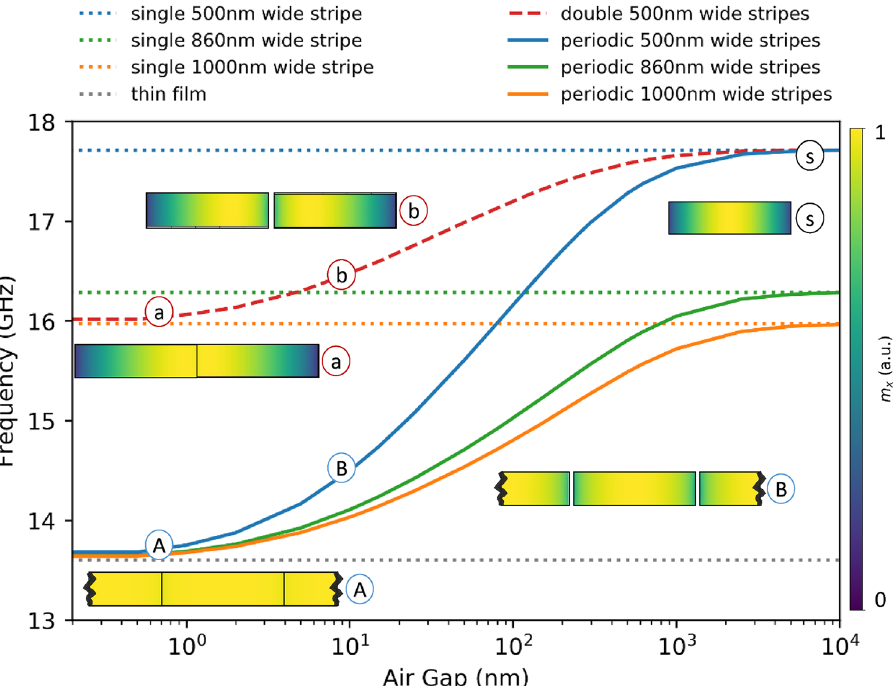
Figure 3. The results show the fundamental mode frequency for individual periodic structures, depending on the width of the air gap (separation) between the magnetic stripes with the widths of 500 nm (blue line), 860 nm (green line), and 1000 nm (orange line), calculated numerically using FEM. The dotted lines present fundamental mode frequencies of the limiting structures - uniform thin CoFeB film, which is the limiting case of the periodic structure of vanishing separation between stripes (grey dotted line), and limits of single stripes, which is the case when stripes are as far that they cannot feel each other any longer—separated dotted lines are presented for each individual width of stripe— w = 500 nm (blue dotted line), w = 860 nm (green dotted line), w = 1000 nm (orange dotted line). The red dashed line shows the FEM result for a structure consisting of only two stripes—the upper limit is a single 500 nm wide stripe, and the lower limit is a single 1000 nm wide stripe. Additionally, the spin wave mode profiles are presented for structures with w = 500 nm: (A) periodic structure with g = 0.5 nm; (B) periodic structure with g = 10 nm; (a) double stripes with g = 0.5 nm; (b) double stripes with g = 10 nm; (s) single